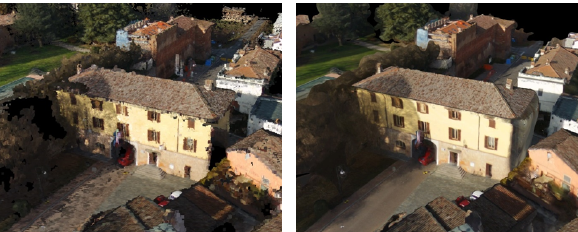
Figure 6. Rectangular flight, point cloud (left) and mesh (right)